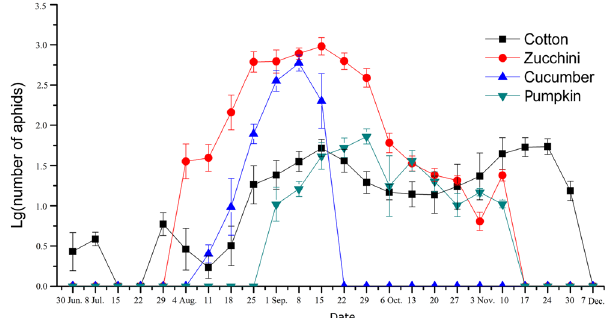
Figure 5. Population dynamics of cotton-melon aphids on intercropped cotton, zucchini, cucumber and pumpkin in 2013 (mean ± SE).